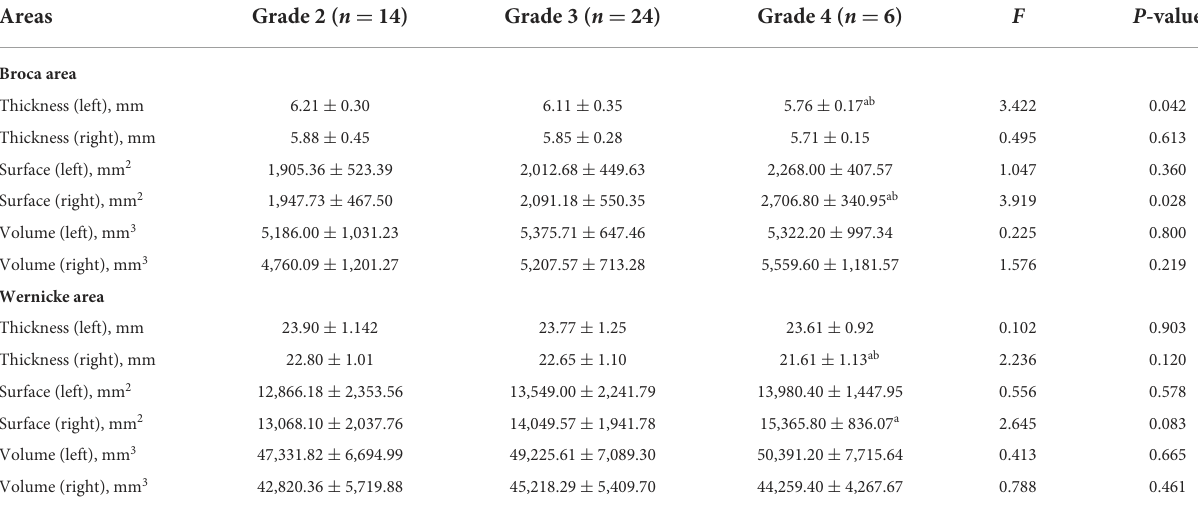
TABLE 4 Differential analysis of CARS language communication classification and brain structures.